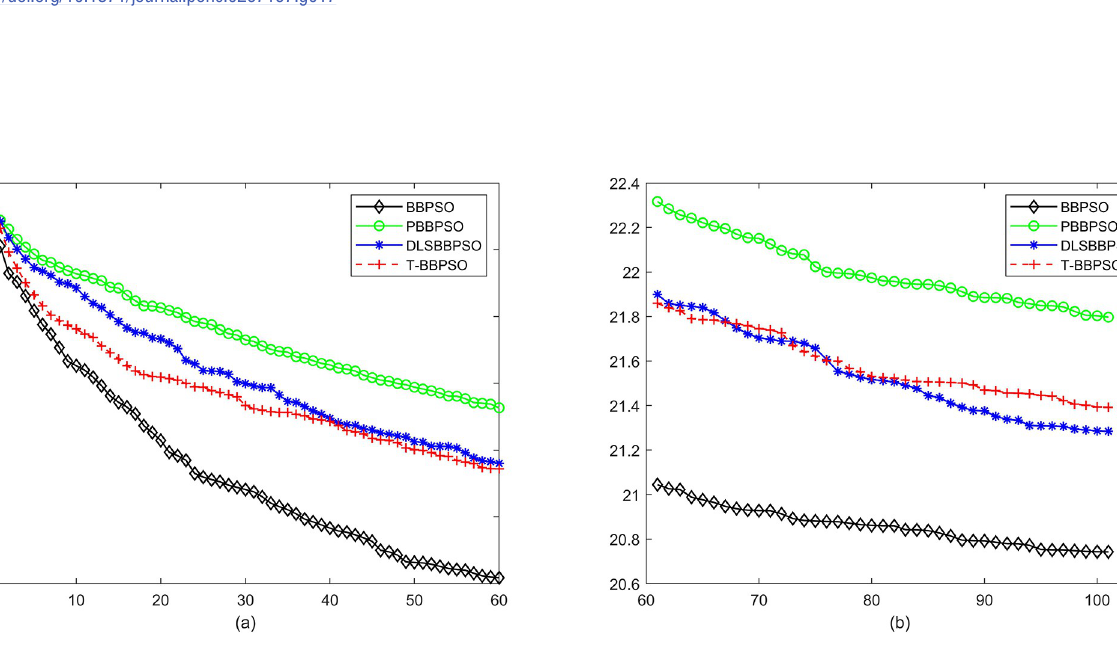
Fig 18. Comparison of convergence speed between BBPSO, PBBPSO, DLS-BBPSO and TBBPSO, f 16 , (a) iteration 0–6000, (b) iteration 6000–10000 the unit is 100 iteration.